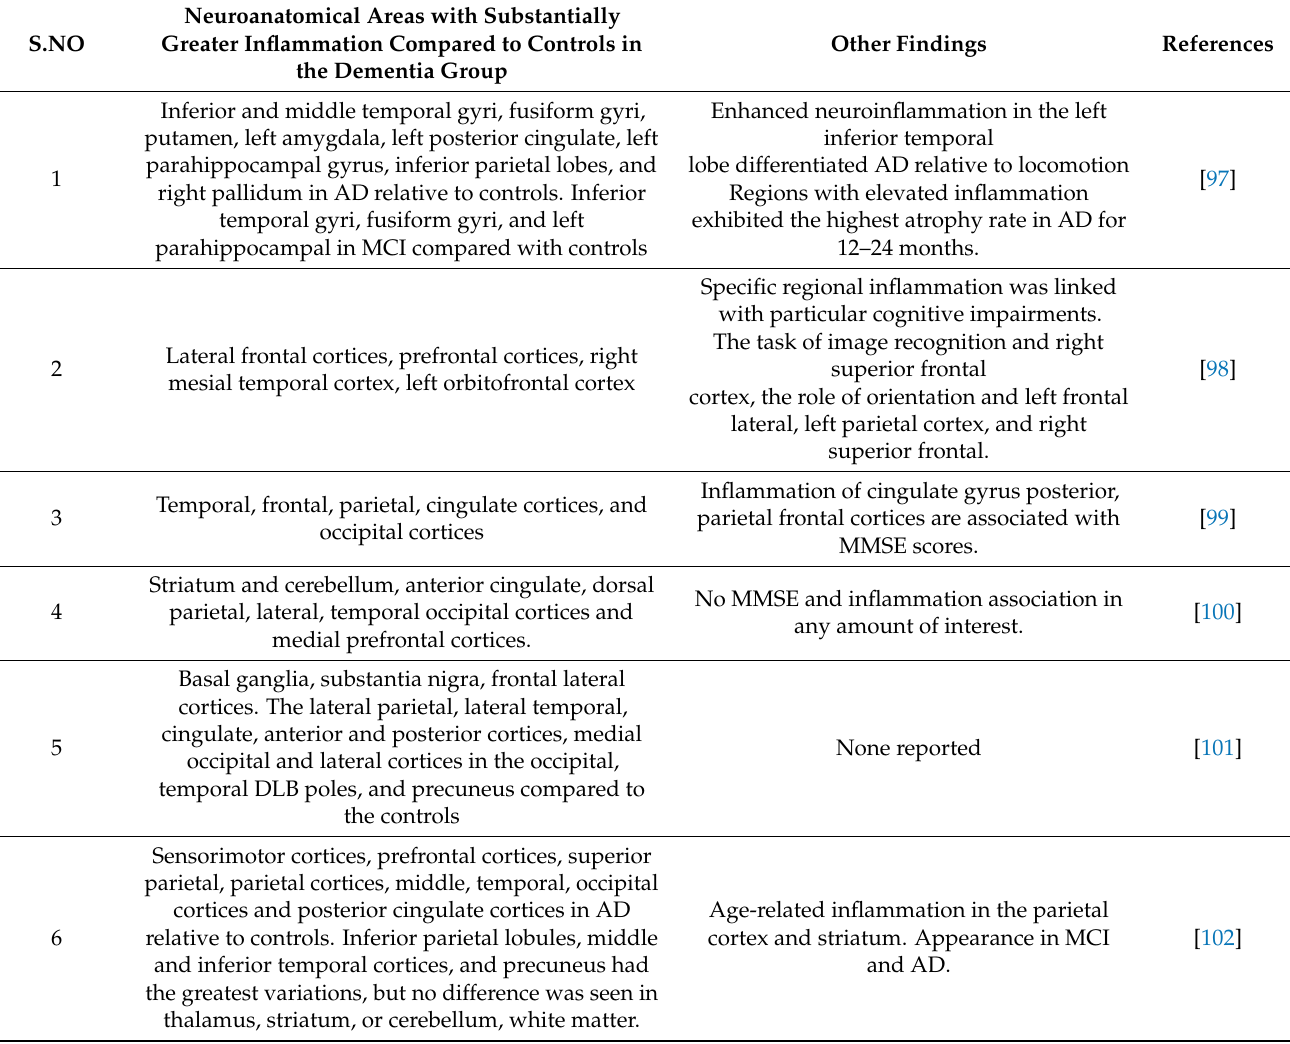
Table 2. Studies using in vivo neuroinflammation imaging for human dementia